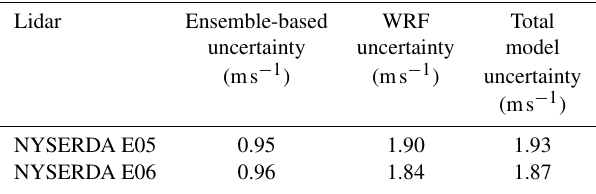
Table 5. Comparison between ensemble-derived uncertainty and total model uncertainty in 140m wind speed at the locations of the two NYSERDA lidars.